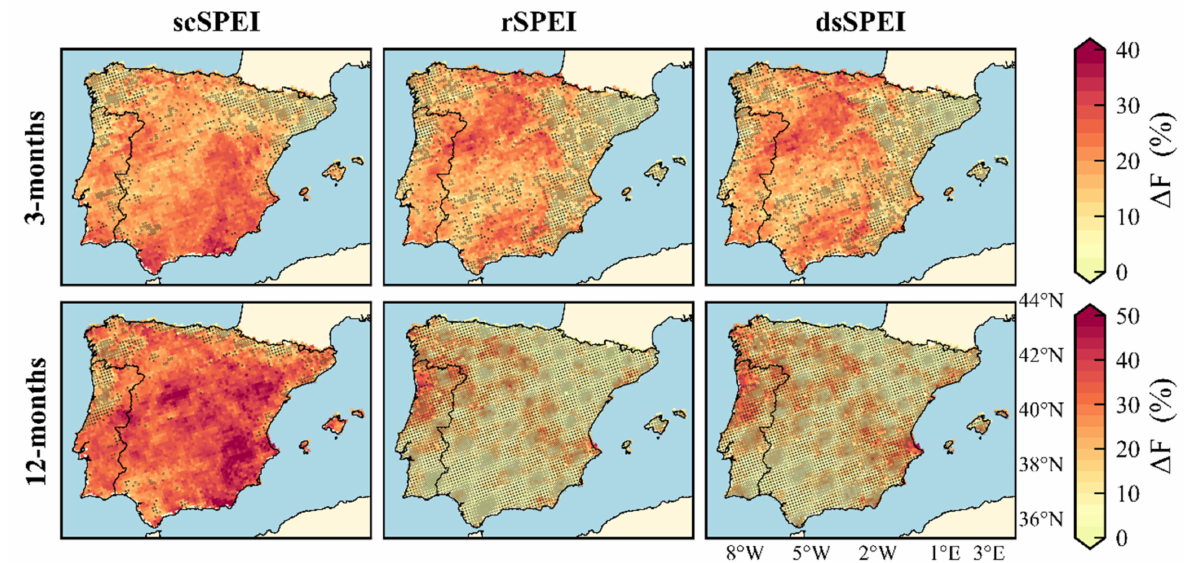
Figure 5. Relative changes in the drought frequency ( ∆ F, %) for the near future (2020–2049) related to the recent past (1980–2009) for the three methods analyzed (scSPEI, rSPEI, and dsSPEI) and at both timescales (3- and 12-month). The dashed areas indicate that less than 12 models agree in the sign of the changes with the ensemble